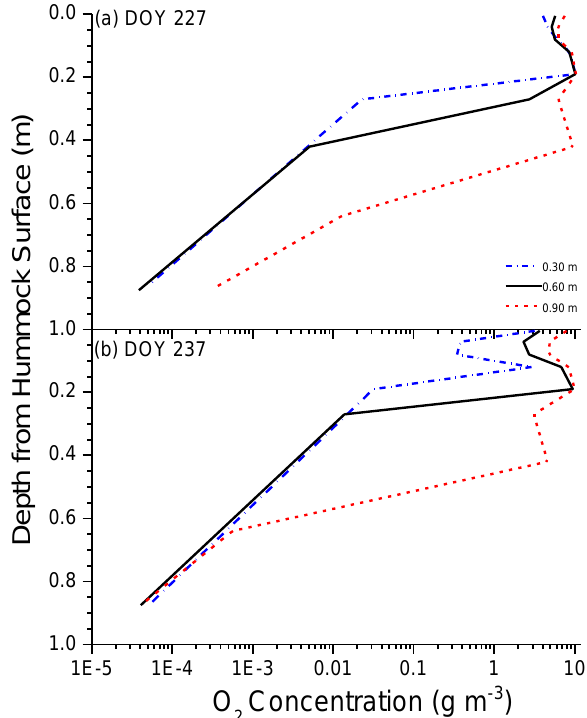
Fig. 11. Vertical profiles of aqueous O 2 concentration ([O 2s ]) mod- elled below hummocks by raising or lowering the depth of the ex- ternal water table from 0.6m (Fig. 1) to 0.3m or 0.9m on DOY 227 and 237 in